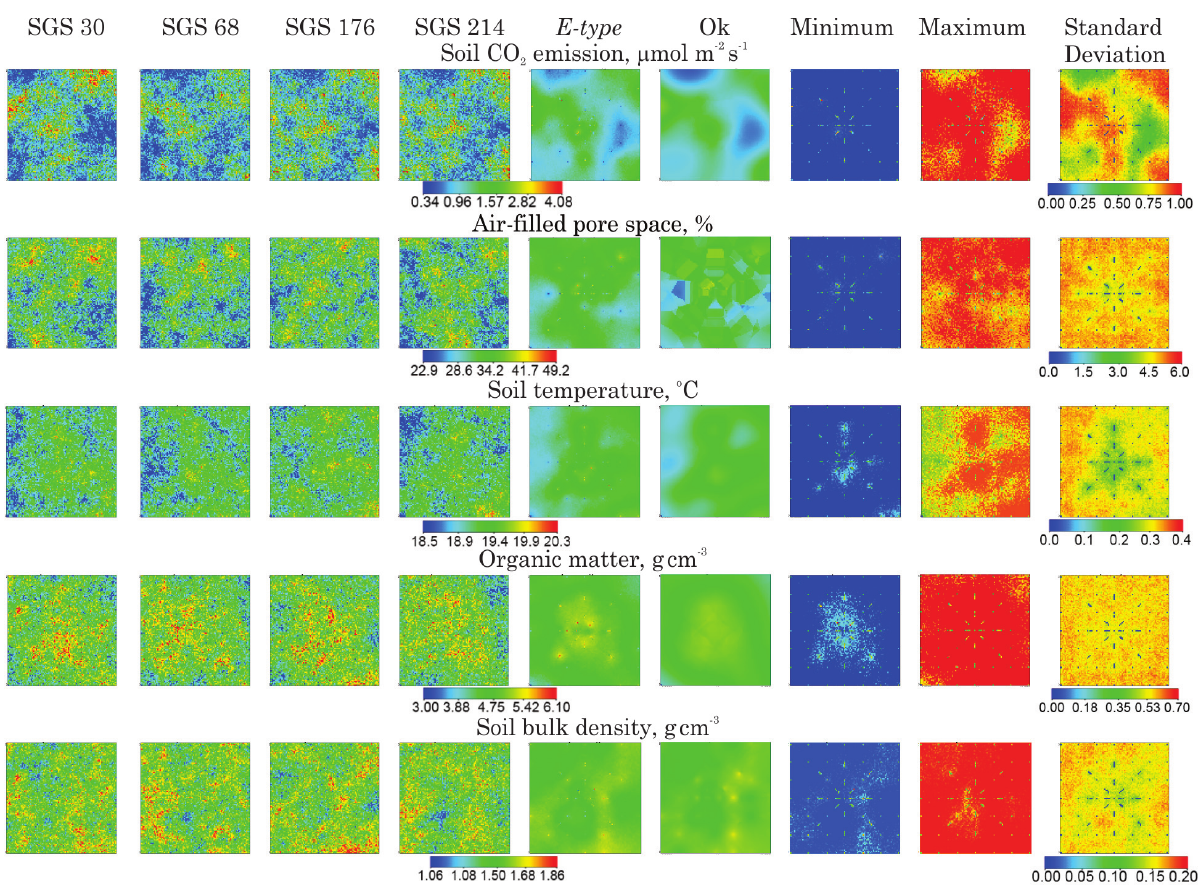
Figure 2. Spatial pattern and deviations maps based on sequential Gaussian simulation (SGS) and ordinary kriging